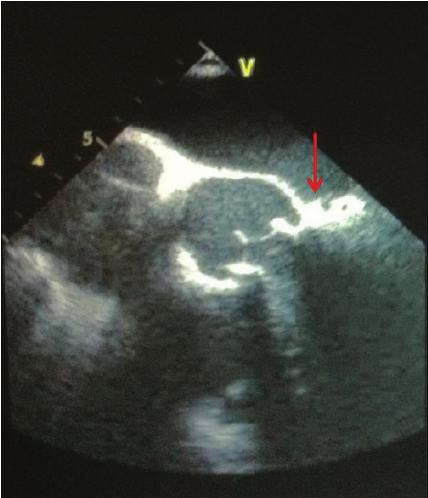
Figure 1: Transesophageal echocardiogram (TEE) showing the aortic valve, mitral valve, and mitral-aortic intervalvular fibrosa (red arrow) with adjacent pseudoaneurysm (P-MAIF).